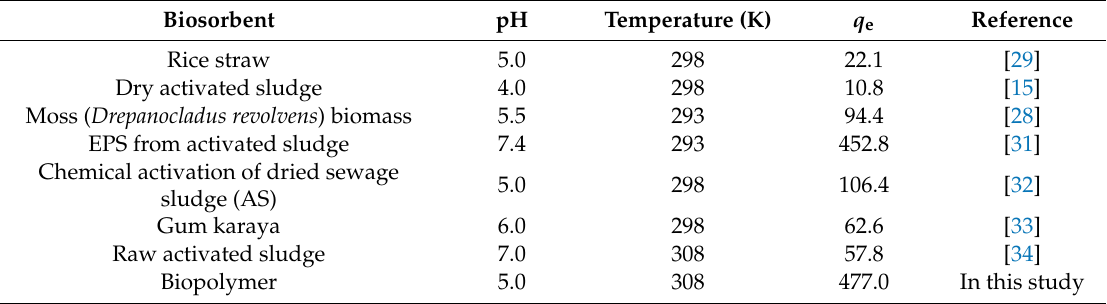
Table 4. Comparison of the maximum adsorption capacity of Hg(II) in literature and this study.